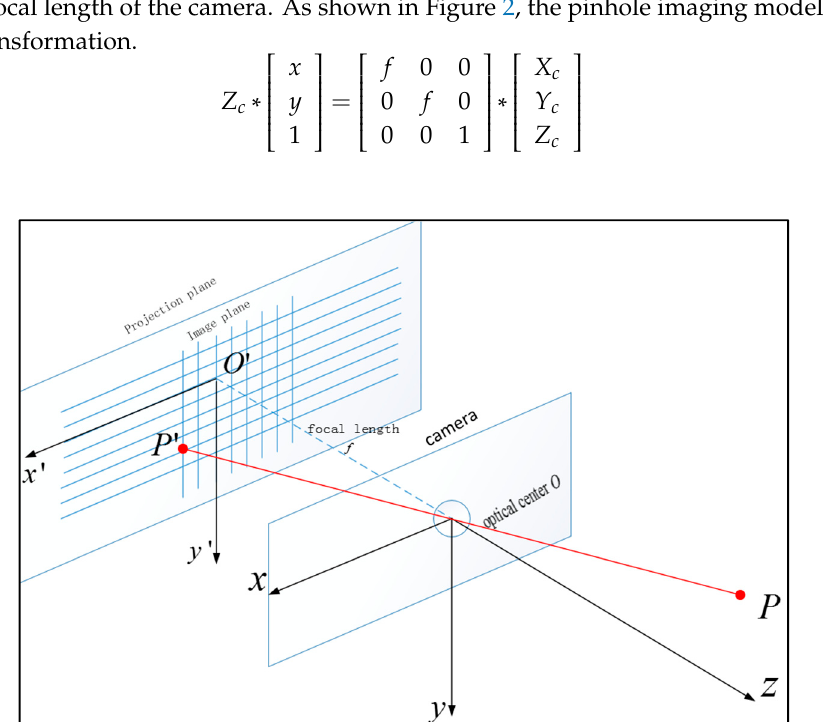
Figure 2. Schematic diagram of pinhole imaging model.